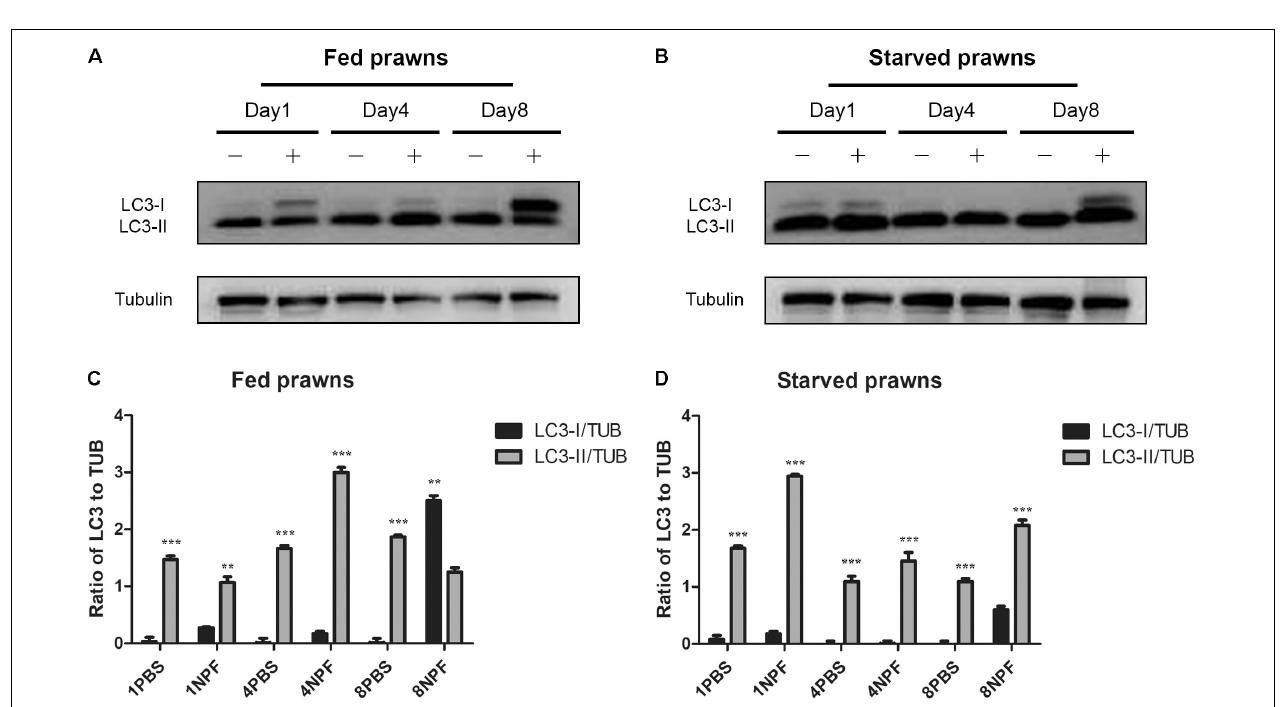
FIGURE 3 | Effects of neuropeptide F and starvation on the hepatopancreas and muscle in male giant freshwater prawns. (A) Mean hepato-somatic index (HSI) of fed and starved prawns injected with PBS or NPF determined at days 1, 4, and 8. (B) Mean musculo-somatic index (MSI) of fed and starved prawns injected with PBS or NPF determined at days 1, 4, and 8. ( ∗ P < 0.05, ∗∗ P < 0.001).